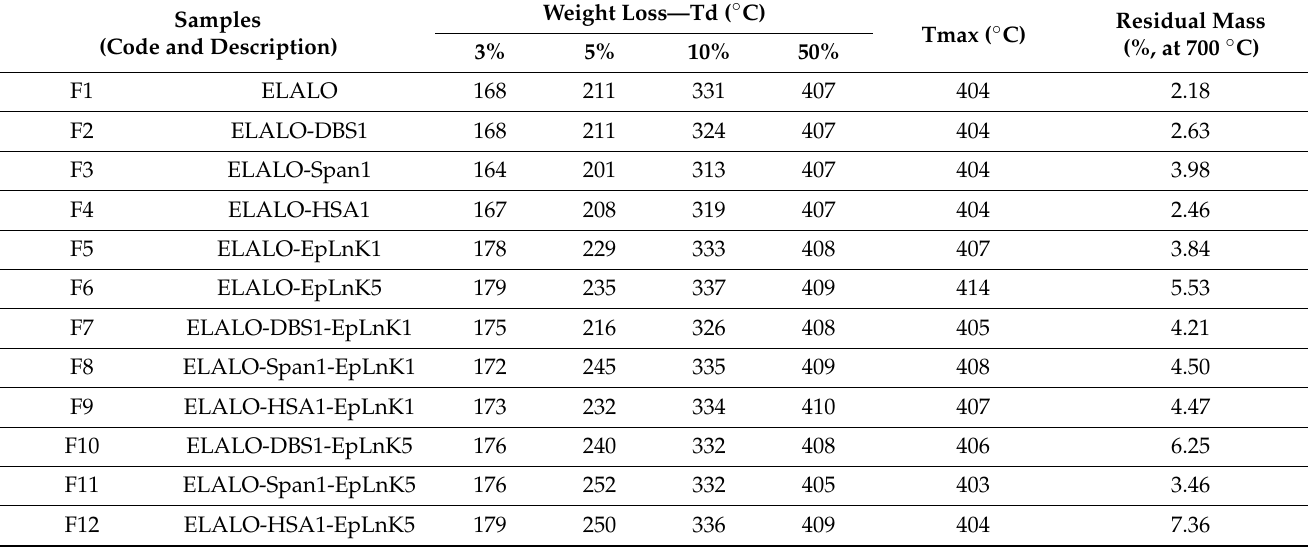
Table 5. TGA (N 2 atmosphere)